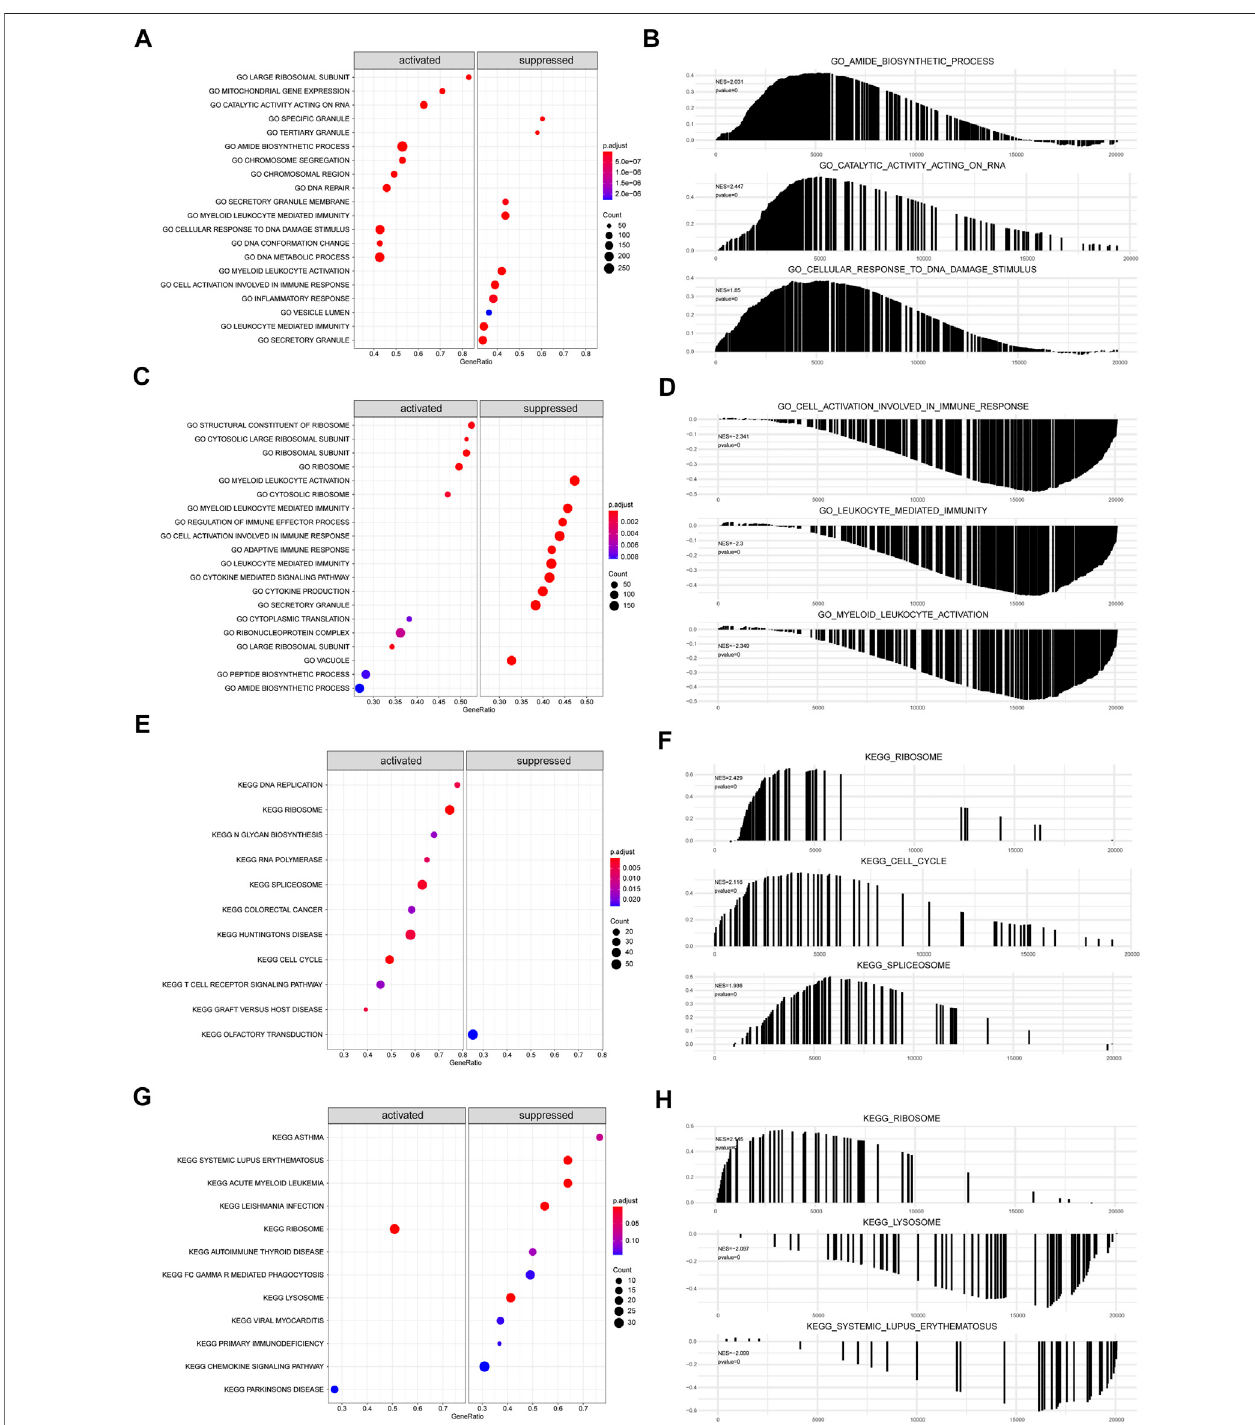
FIGURE 7 | GSEA analysis. (A,C) For GSEA-GO enrichment analysis of two sets of mRNA data, the node color indicates the signi fi cant level of GO-term enrichment, and the node size indicates the number of genes enriched in the GO-term. (B,D) Top three presentations of GSEA-GO enrichment analysis results for both mRNAdatasets. (E,G) GSEA-KEGGenrichmentanalysisoftwosetsofmRNAdata.Thenodecolorsindicatethesigni fi canceofpathwayenrichment,whilethenodesize indicates the number of genes enriched in the pathways. (F,H) Top three presentations of GSEA-KEGG enrichment analysis results for both mRNA datasets.